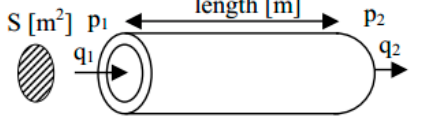
Figure 6. Tube Figure 7. Tube model.